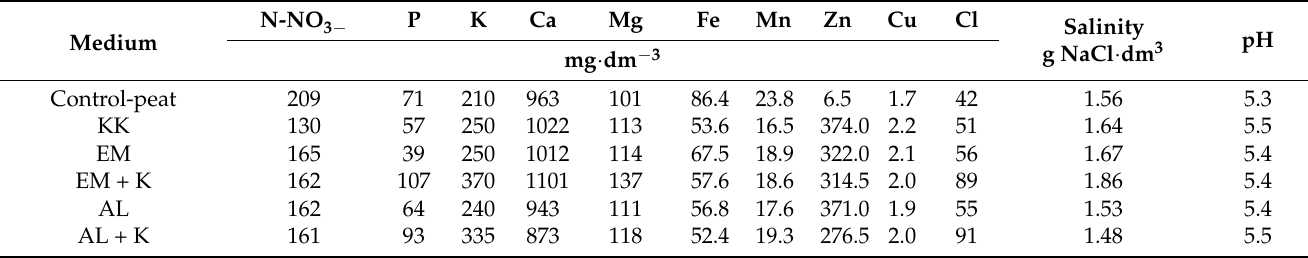
Table 3. The chemical composition of the composts before mixing of potting growing medium.